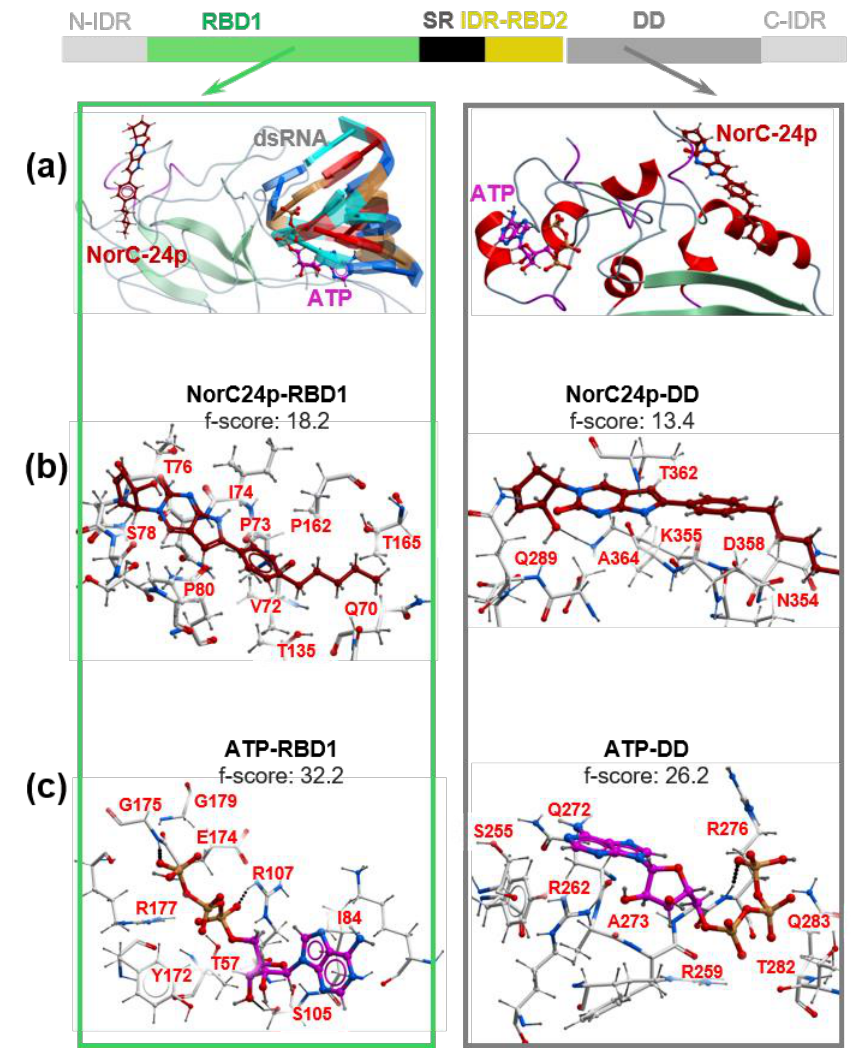
Figure 5. Molecular modeling of NorC-24p and ATP interactions with N protein. ( a ) Key binding sites revealed by docking of NorC-24p and ATP to N-protein RBD1 and DD. ( b ) Best-scoring conformations of NorC-24p complexes with N and respective scoring functions. ( c ) Best-scoring conformations of ATP complexes with N and respective scoring functions.